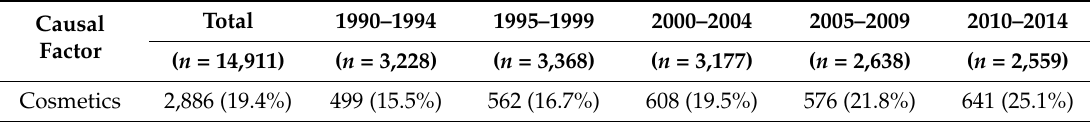
Table 1. Trends in frequency over five-year periods of cosmetic dermatitis in patients tested between 1990 and 2014 ( n = 14,911).